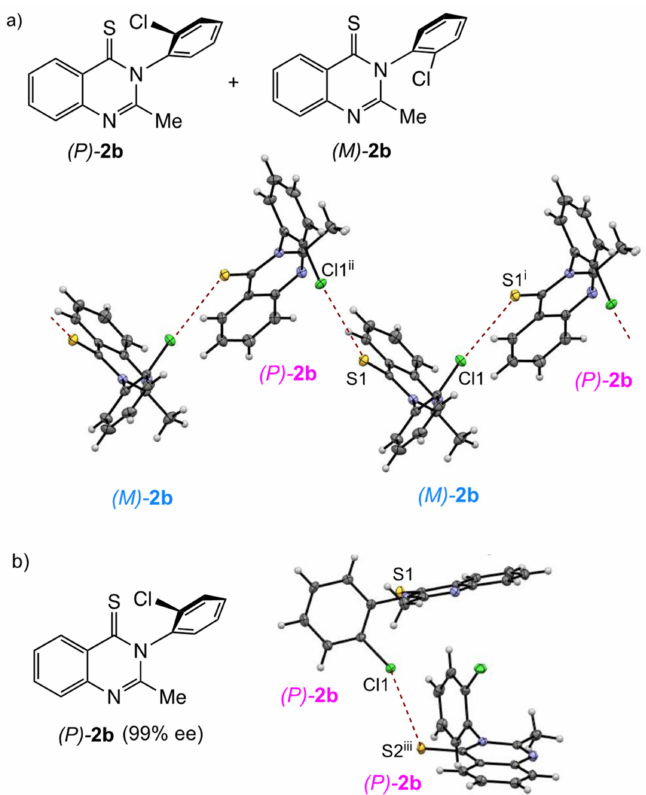
Figure 5. Parts of the packing structure of ( a ) racemic 2b and ( b ) ( P )- 2b at 100 K with 50% probability thermal ellipsoids. Symmetry operations: (i) 1/2 − x, 1/2 + y, z, (ii) 1/2 − x, − 1/2 + y, z; (iii) x, y, 1 + z.